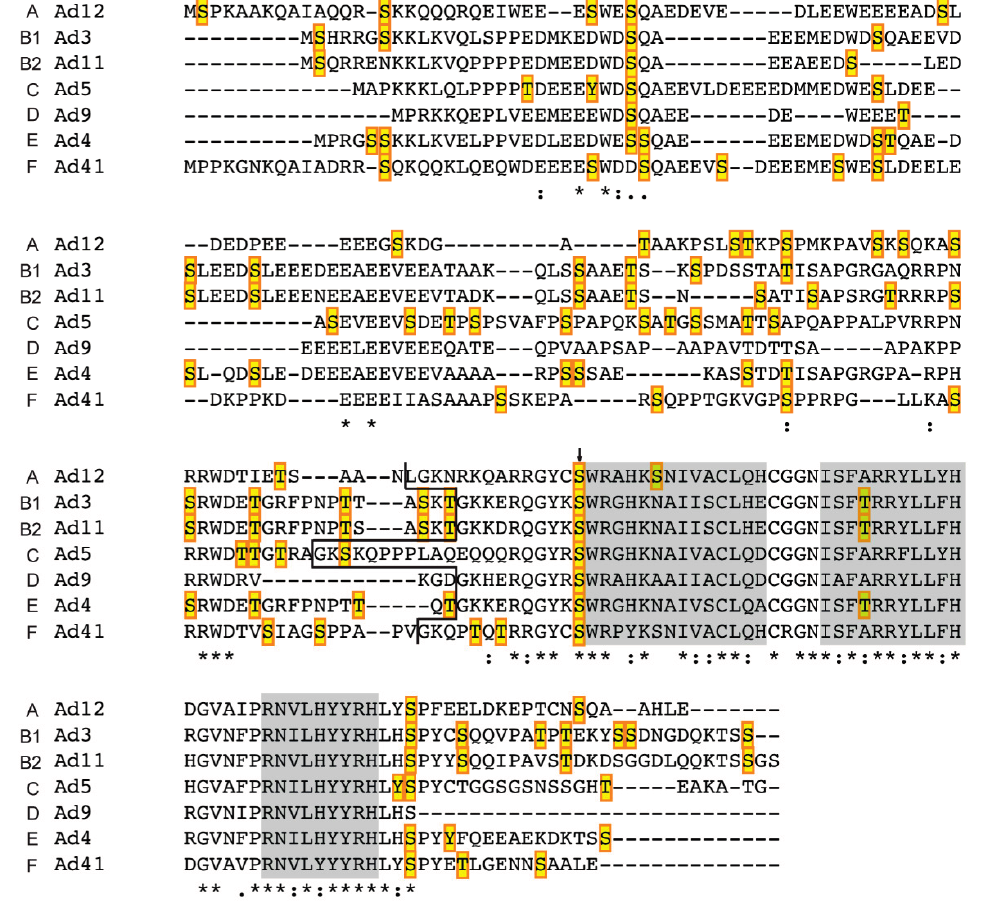
Figure 4. Alignment of L4-22K proteins from different human serotypes and their putative phosphorylation sites. The amino acid sequence of the indicated L4-22K proteins was aligned using the Clustal Omega software. The conserved residues are indicated by star ( * ), colon (:), and period (.) according to the level of identity and similarity of the amino acid aligned: full identity, amino acids with similar characteristics, and weakly similar residues, respectively. The black line separates the N -terminal part (shared with the respective L4-33K) and the C -terminal region of each serotype. The predicted helical domains identified by Predict Protein on the Ad5 L4-22K polypeptide sequence are shown in the grey boxes. The putative phosphorylation sites detected with NetPhosK 1.0 are marked in yellow boxes and the arrow indicates the conserved residues predicted to be phosphorylated by the same kinase (see also Table